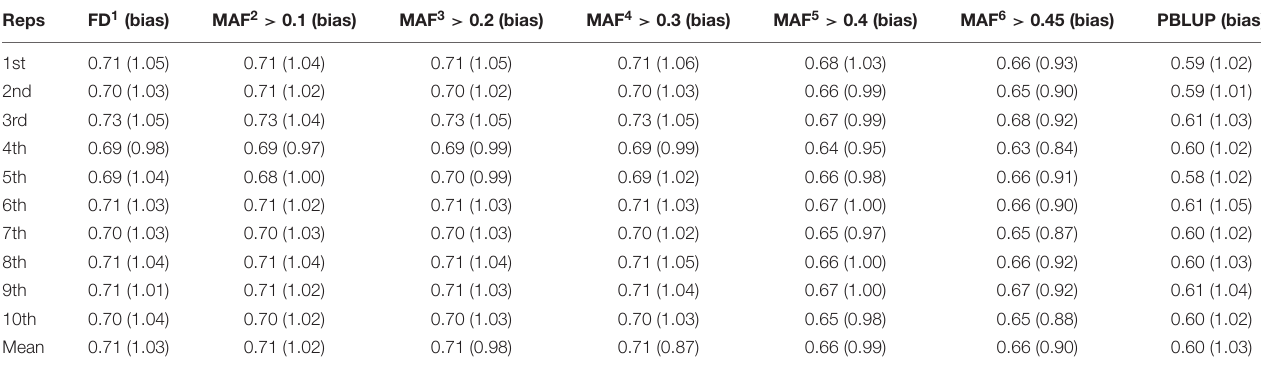
TABLE 2 | Mean accuracy of pedigree BLUP (PBLUP) and GBLUP using SNP of varying MAF obtained from 10 repeats of fivefold